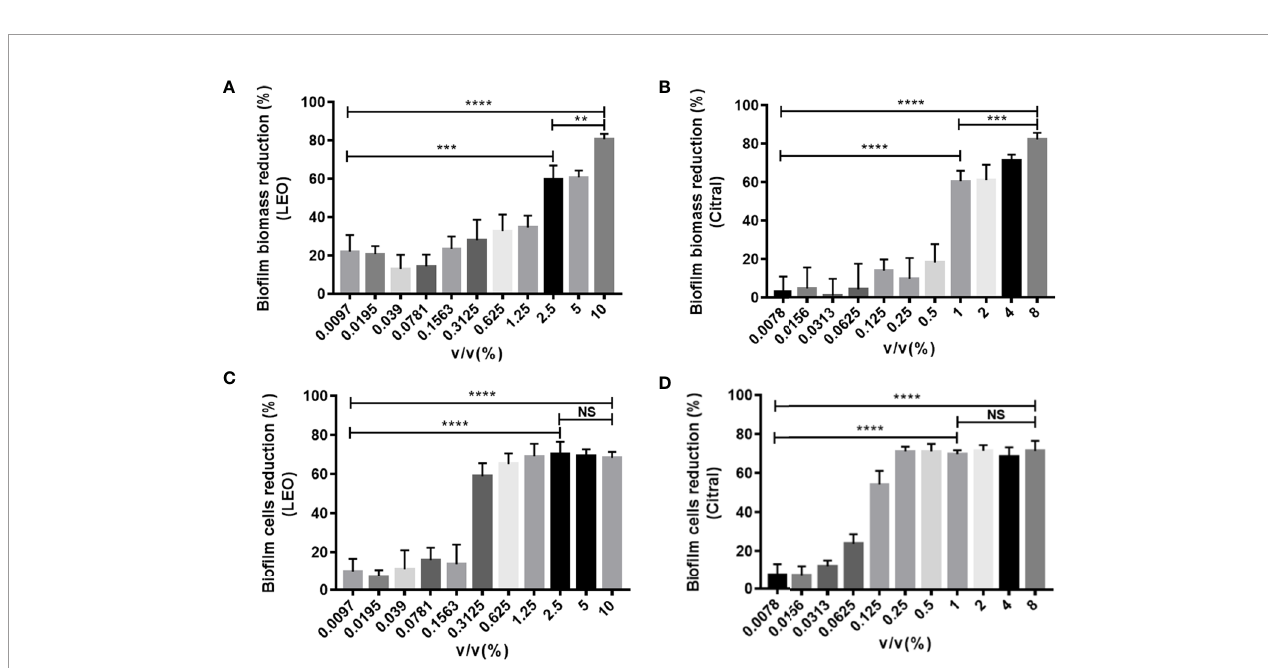
FIGURE 3 | Antibio fi lm activity of lemongrass essential oil or citral on dual-species bio fi lms of C. tropicalis and S. aureus after 24 h treatment. (A) Effect of lemongrass essential oil on bio fi lm biomass. (B) Effect of citral on bio fi lm biomass. (C) Effect of lemongrass essential oil on cell viability in bio fi lm. (D) Effect of citral on cell viability in bio fi lm. Data are shown as mean ± SD (n=3). **p < 0.01, ***p < 0.001, ****p < 0.0001, NS, No Signi fi cance; LEO, lemongrass essential